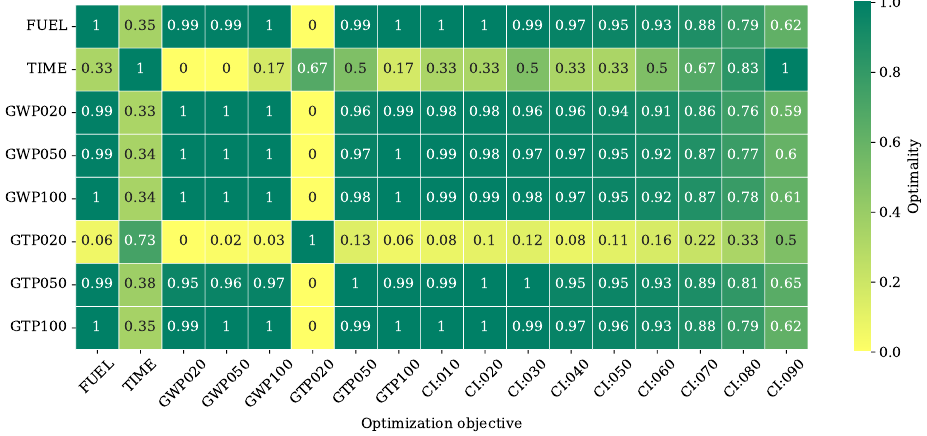
Figure 6. Optimality metric using different objectives. A higher value indicates two objectives are more similar, and lower value indicates larger